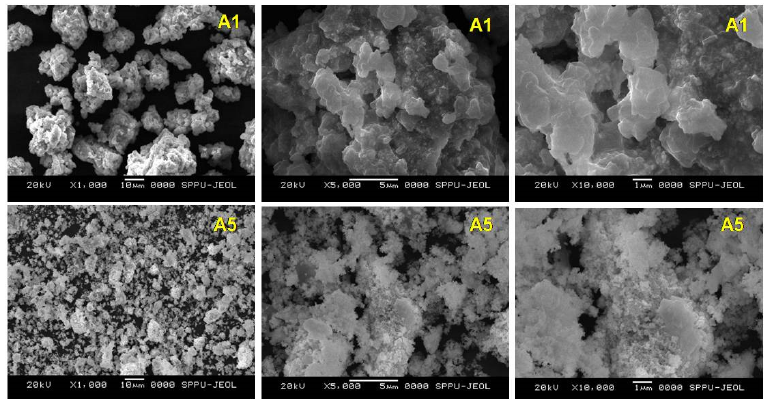
Figure 7. Scanning Electron Microscope (SEM) images of the sample at various magnifications of sample preparation.